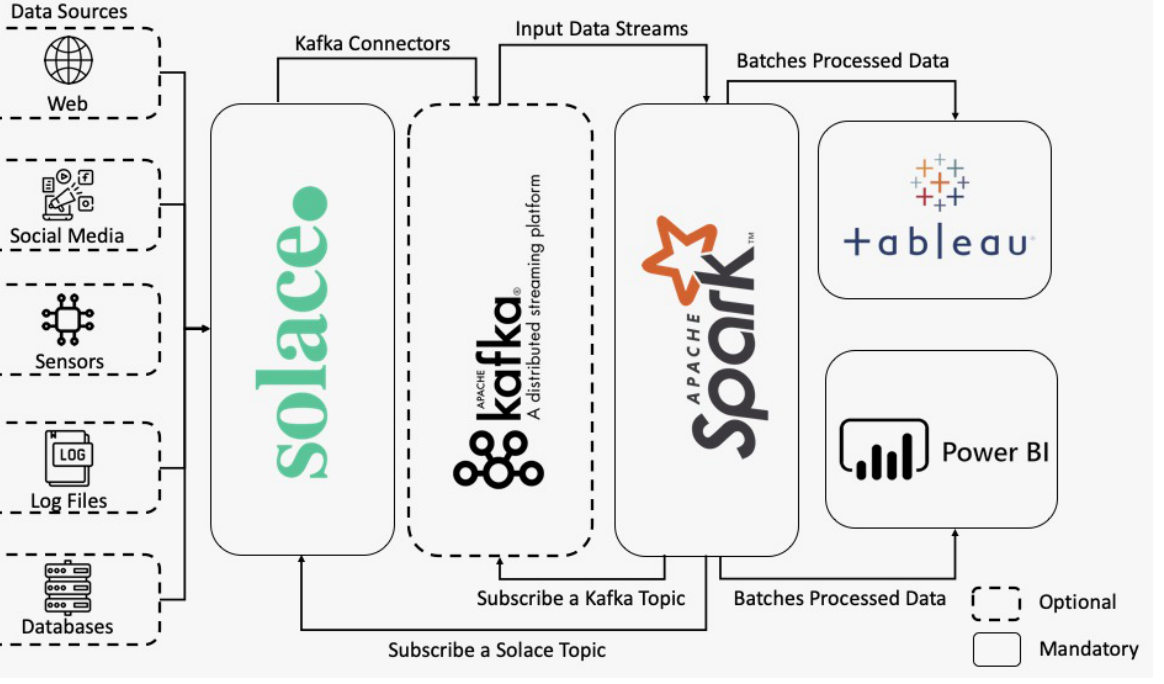
Figure 9. Proposed hybrid